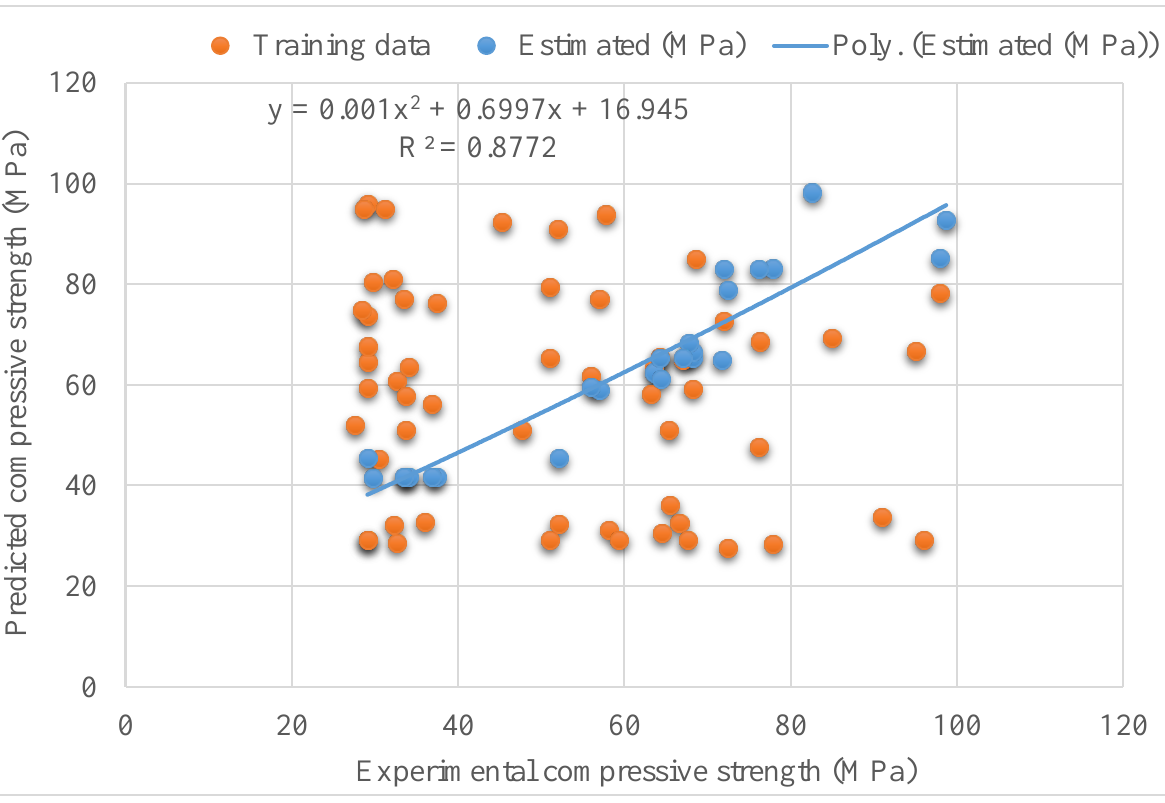
Figure 7. Experimental and estimated outcome relationship for SVR bagging model.